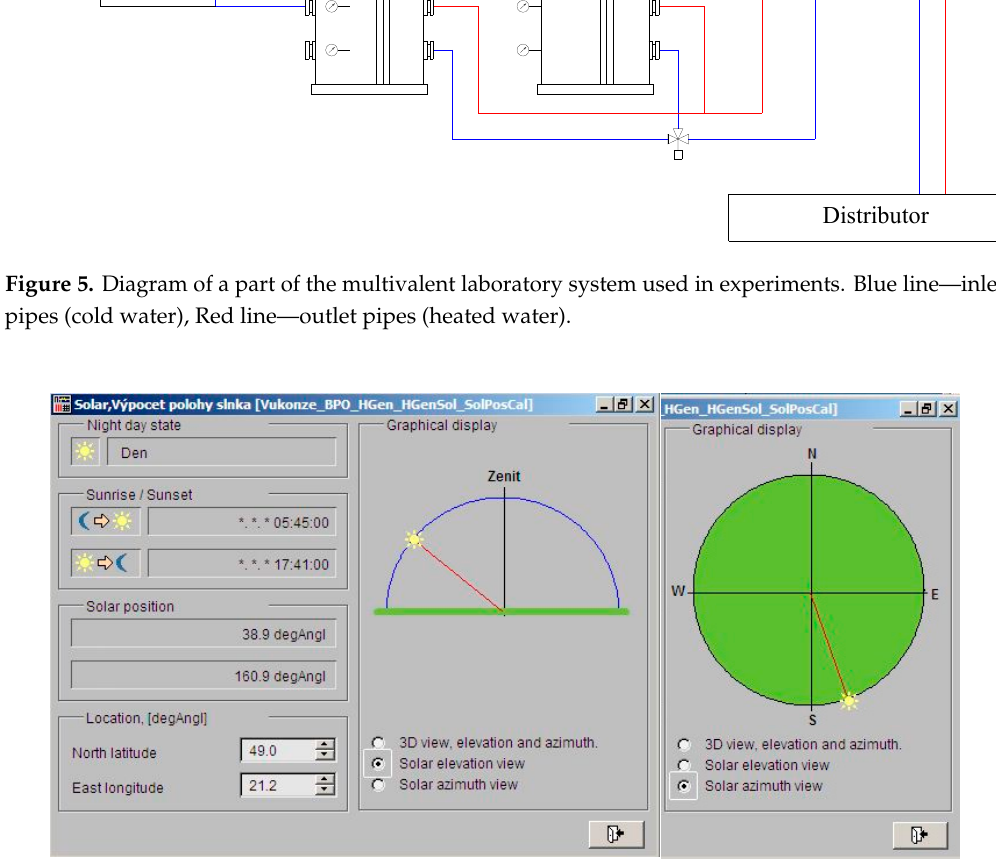
Figure 5. Diagram of a part of the multivalent laboratory system used in experiments. Blue line –